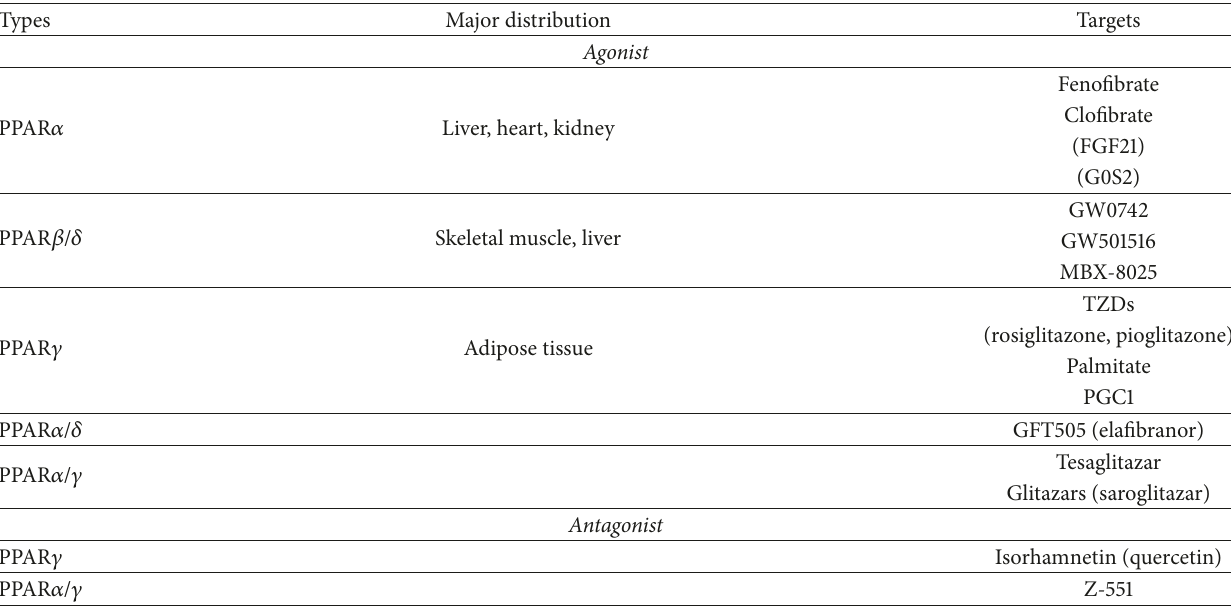
Table 1: PPARs expression and respective